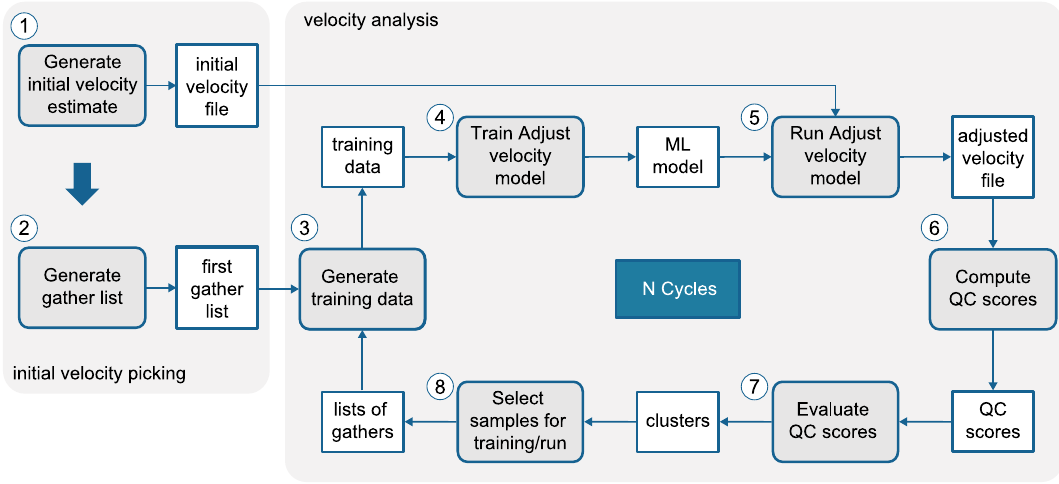
Figure 2. VA use case. The numbers show the order of execution and the gray blocks highlight the sequence of operations that composes the